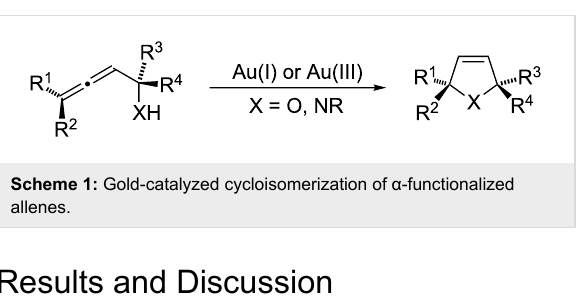
In 2007, we reported a synthesis of furanomycin derivatives by gold-catalyzed endo -selective cycloisomerization of α -hydroxy- allenes [19]. This method opens an efficient stereoselective access to chiral 2,5-dihydrofurans by axis-to-center chirality transfer (Scheme 1) [21-32] and was applied to the total syn- thesis of various natural products [29-37]. Likewise, the corres- ponding gold-catalyzed cycloisomerization of various protected or unprotected α -aminoallenes affords 2,5-dihydropyrroles [29- 32,38,39]. Due to the difference in biological activity of fura- nomycin ( 1a ) and carbafuranomycin ( 1b ), we became inter- ested in the synthesis of derivatives of the (so far unknown) azafuranomycin ( 1c ). Here, we describe the first results of this